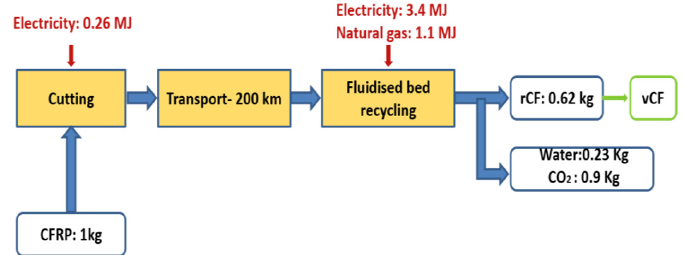
Figure 21. Flow diagram of Fluidized Bed recycling.